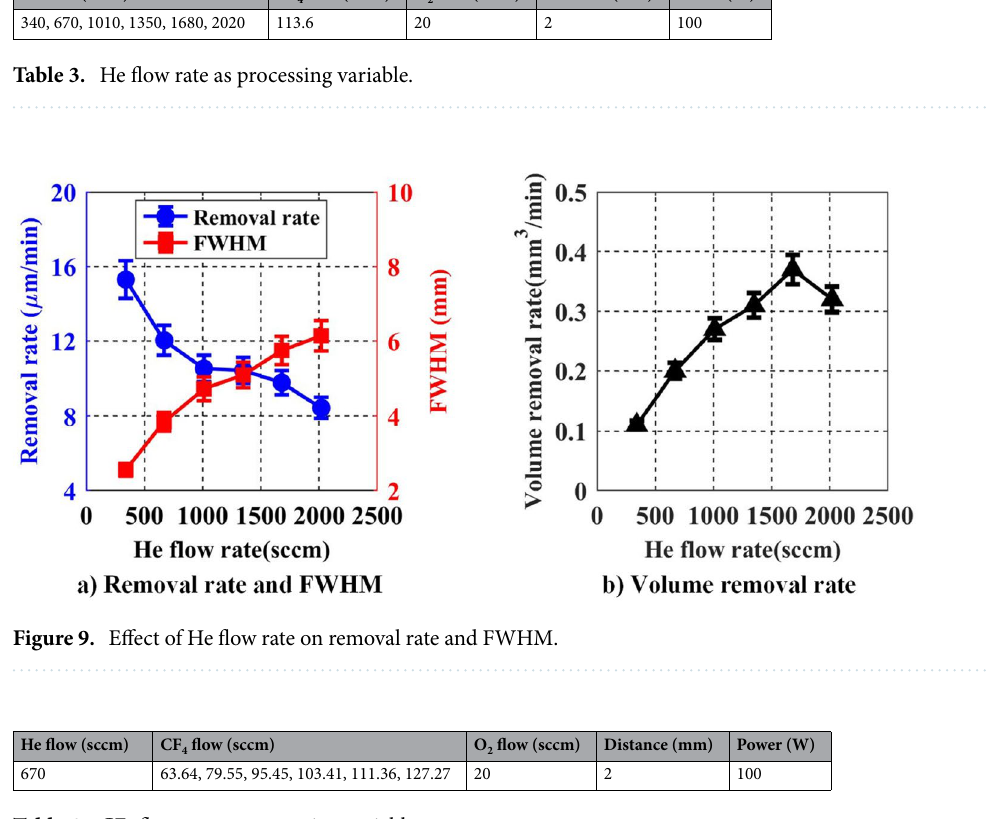
Table 4. CF 4 flow rate as processing